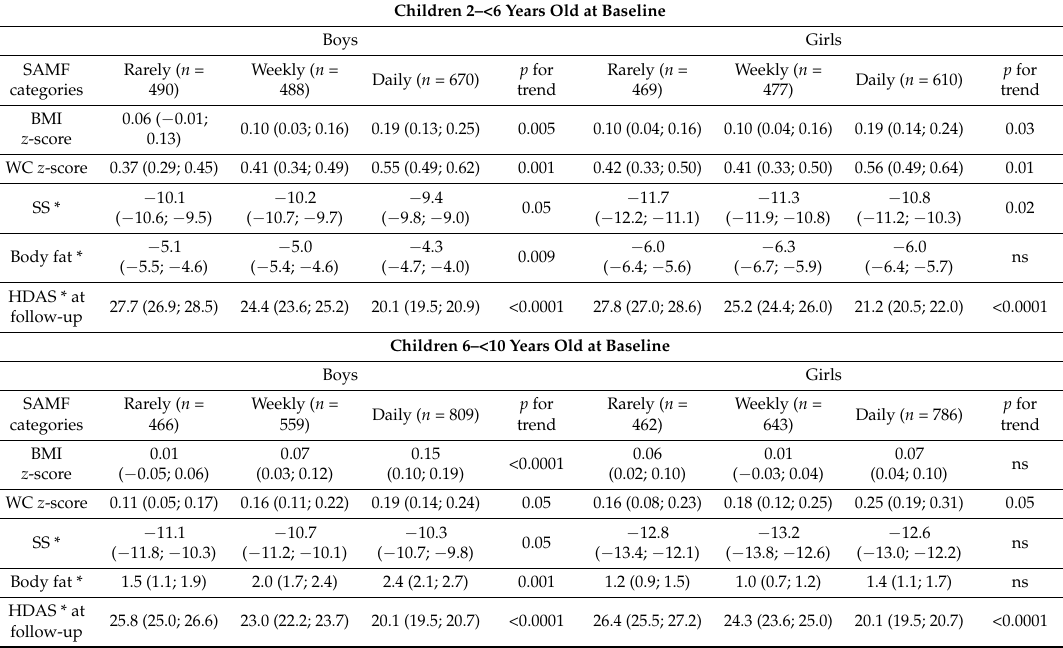
Table 3. Changes in anthropometric variables and HDAS over the two-year follow-up across the SAMF defined at